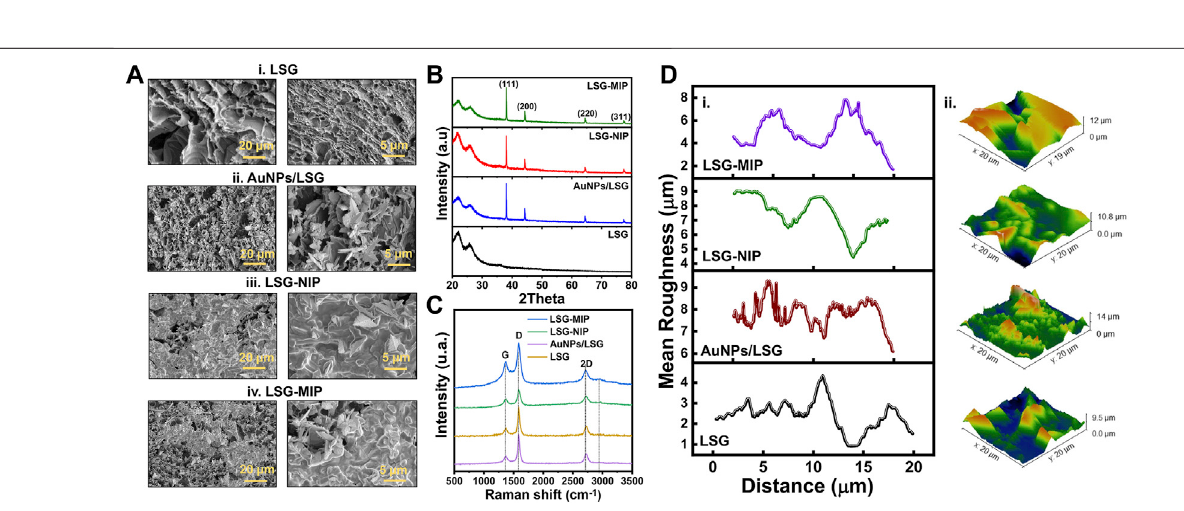
Supplementary Figure S4 . The C 1s high-resolution spectrum shows the characteristic peaks of the C=C bonds of graphene. In addition, the peaks located at 85.3 and 89.9 eV were the characteristic peaks of Au 4f 7/2 and Au 4f 5/2 belonging to the